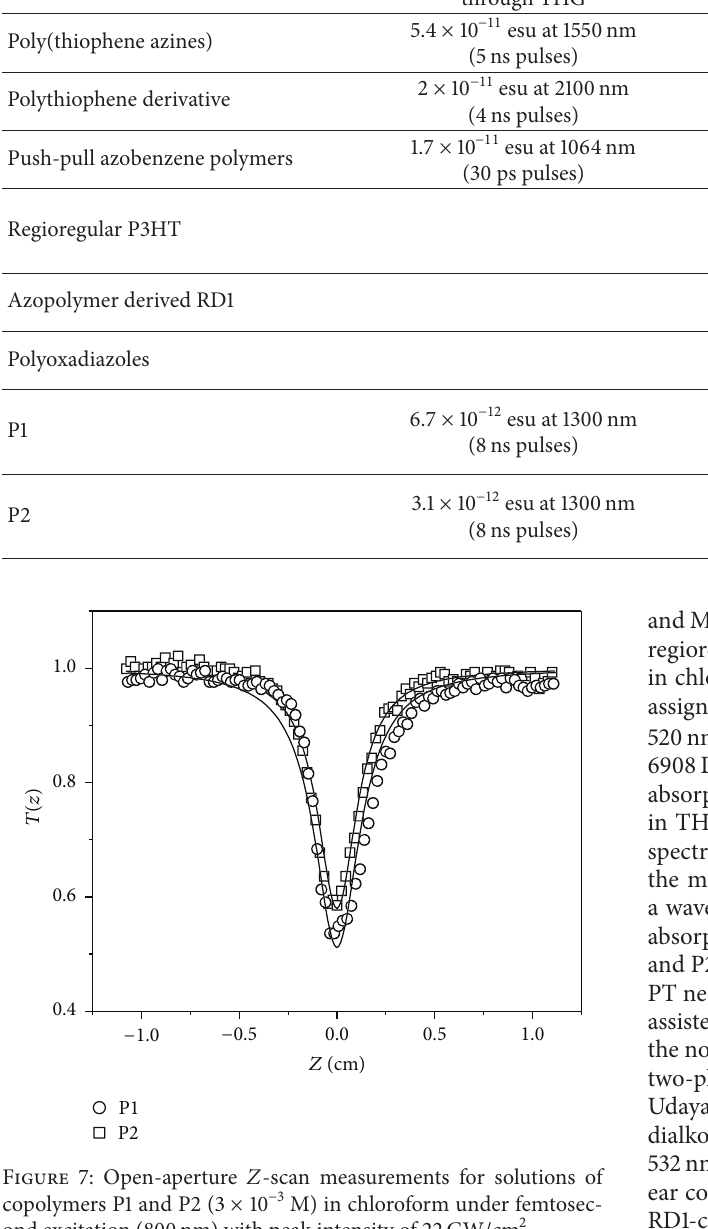
Table 2: Comparative analysis of 𝜒 (3) value obtained by THG and 𝜎 Polymers